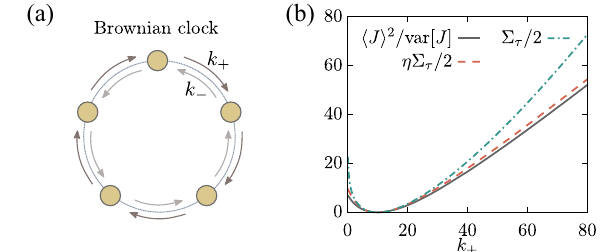
FIG. 2. Numerical illustration of the thermodynamic uncer- tainty relations. (a) Schematic of the five-state Brownian clock and (b) numerical verification. The current precision h J i 2 = var ½ J (cid:2) , new bound η Σ τ = 2 , and conventional bound Σ τ = 2 are indicated by the solid, dashed, and dash-dotted lines, respectively. The forward rate k is varied, whereas the backward rate k − is fixed at þ k − ¼ 10 . The operational time is fixed at τ ¼ 1